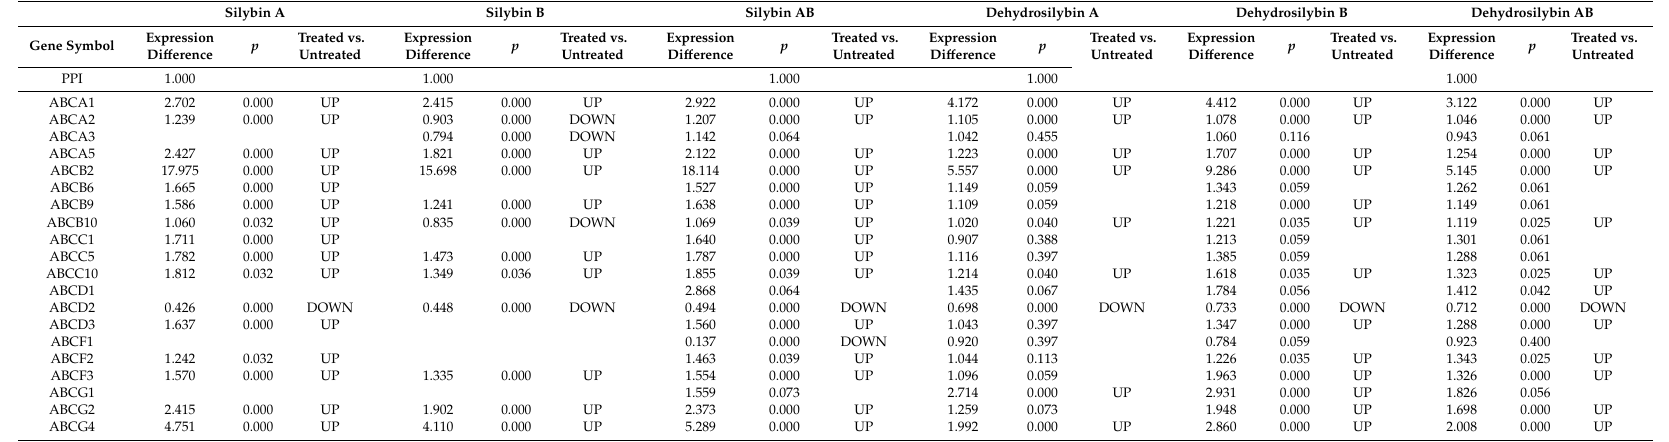
Table A2. E ff ect of silybin and dehydrosilybin isomers combined with doxorubicin at IC 25 on expression of ABC (ATP-binding cassette) superfamily genes in doxorubicin-resistant ovarian carcinoma (A2780 / DOX). SilybinA SilybinB SilybinAB DehydrosilybinA DehydrosilybinB DehydrosilybinAB GeneSymbol Expression Di ff